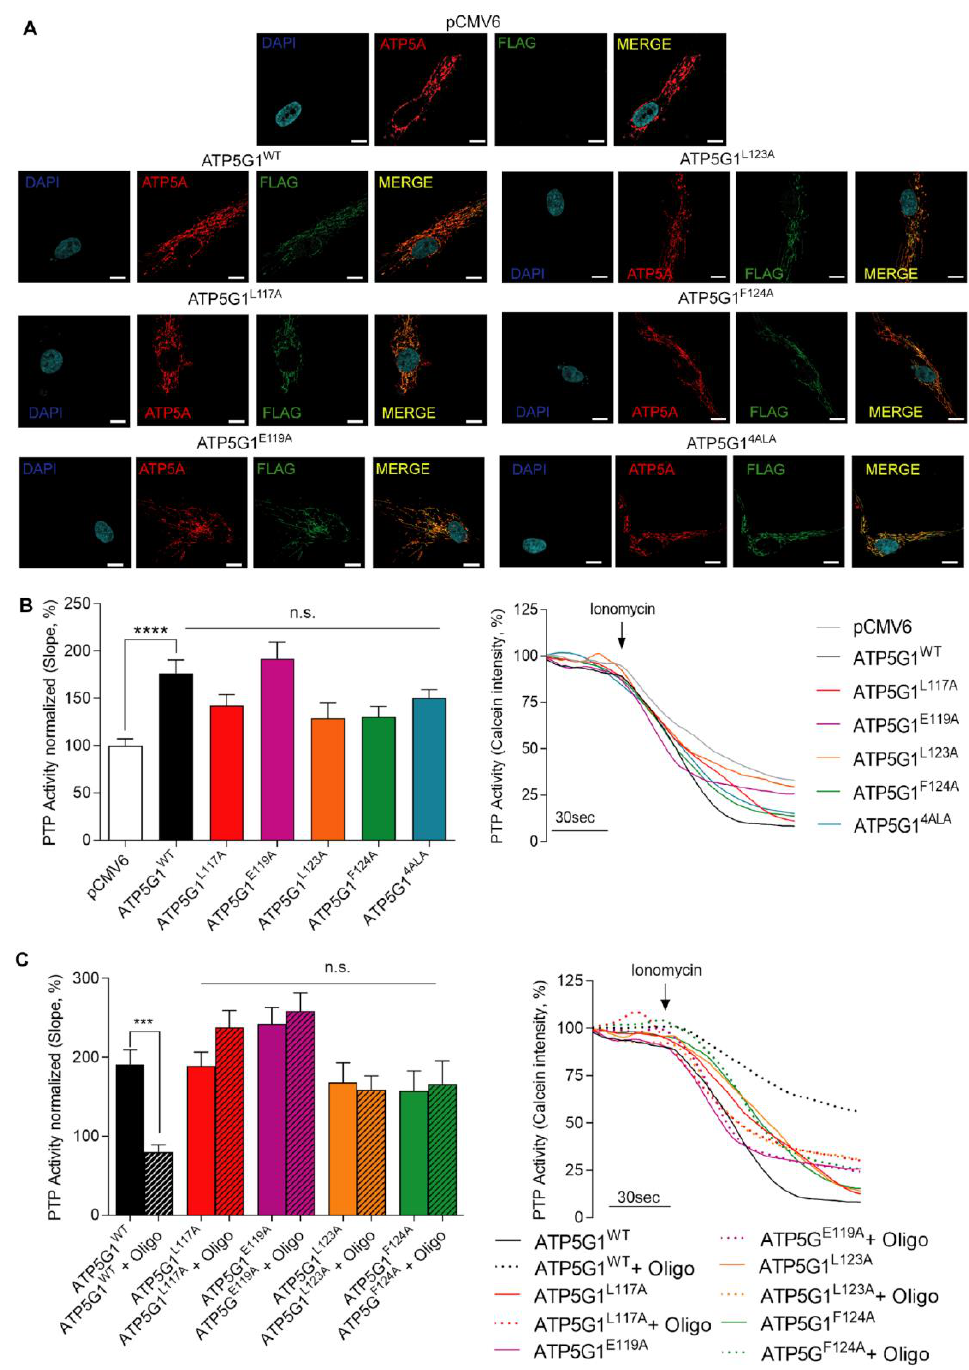
Figure 2. Functional analysis of Oligomycin A-Csub binding in PTP inhibition in primary human cardiac fibroblasts. ( A ) Immunofluorescence assay for mitochondrial localization of mutants: FLAG- tag (green), ATP5A as mitochondrial marker (red), and nuclei (blue, DAPI). Scale bar in white is 10 μm. ( B ) PTP activity measurement (left, analysis of PTP activity; right, representative kinetics) with mutants expressed in HCF and compared with pCMV6 and ATP5G1 WT . ( C ) PTP activity measurement (left, analysis of PTP activity; right, representative kinetics) with mutants expressed in HCF with or without Oligomycin A pre-treatment (10 μM, 30 min). Graphs show mean ± SEM. Statistical differences were analyzed by one-way ANOVA. ***, p < 0.001; ****, p < 0.0001, n.s. not statistically significant.